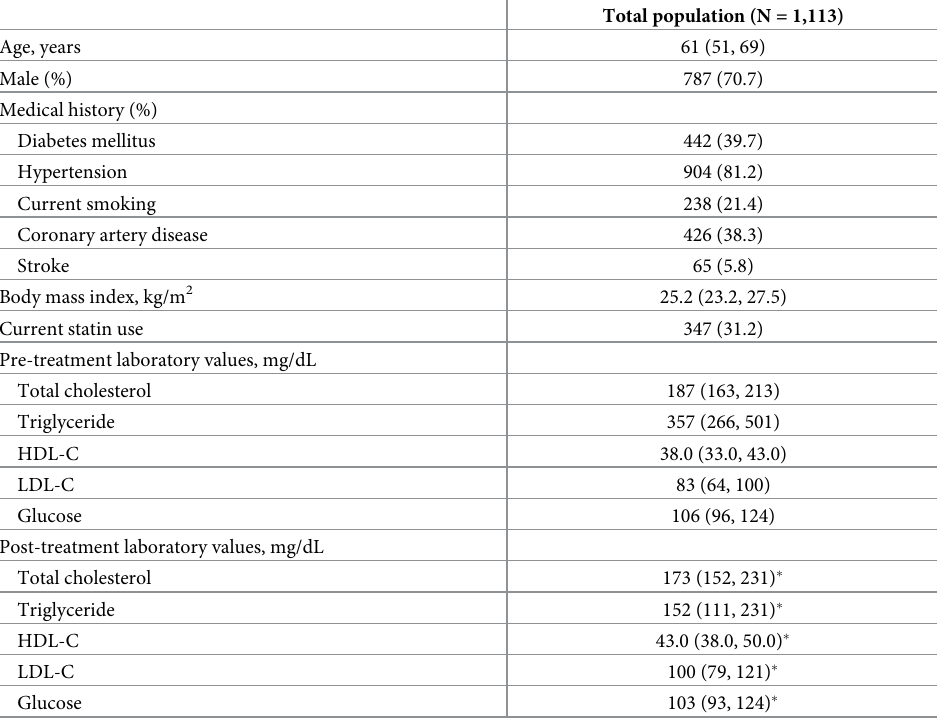
Table 1. Clinical and laboratory parameters of the study population.